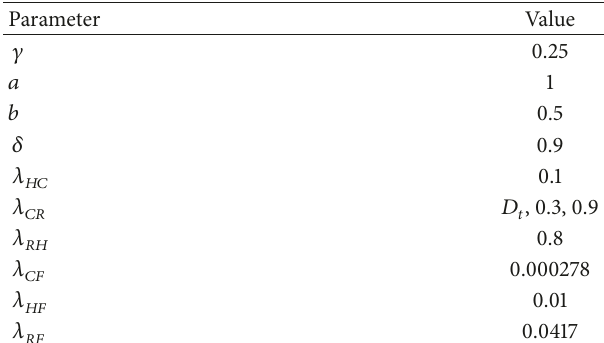
Table 2: The parameter value.